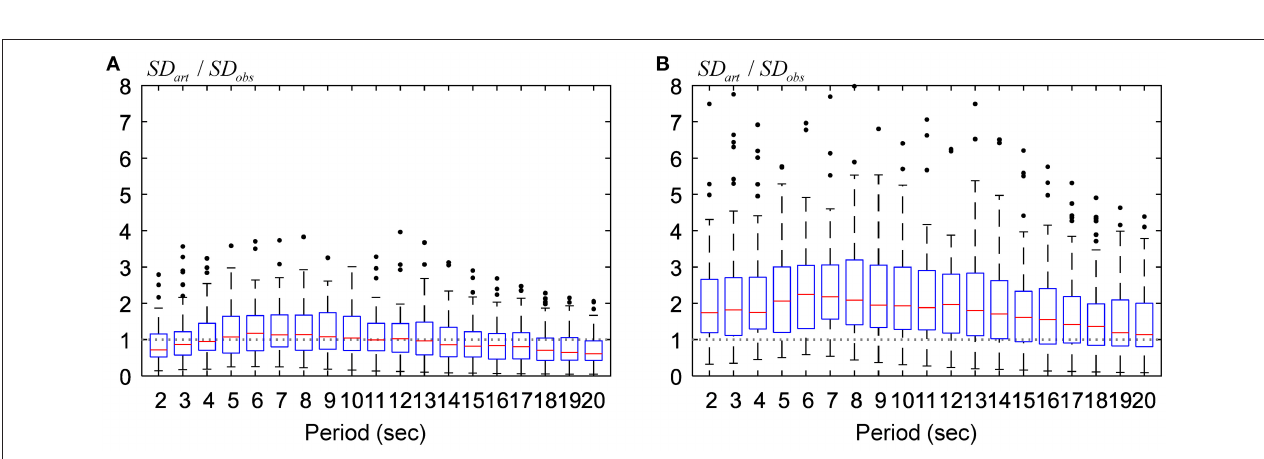
FIGURE 13 | Box-and-whisker plot of ratio of displacement response to art wave to that to observation wave. (A) Recipe model. (B) Critical model.